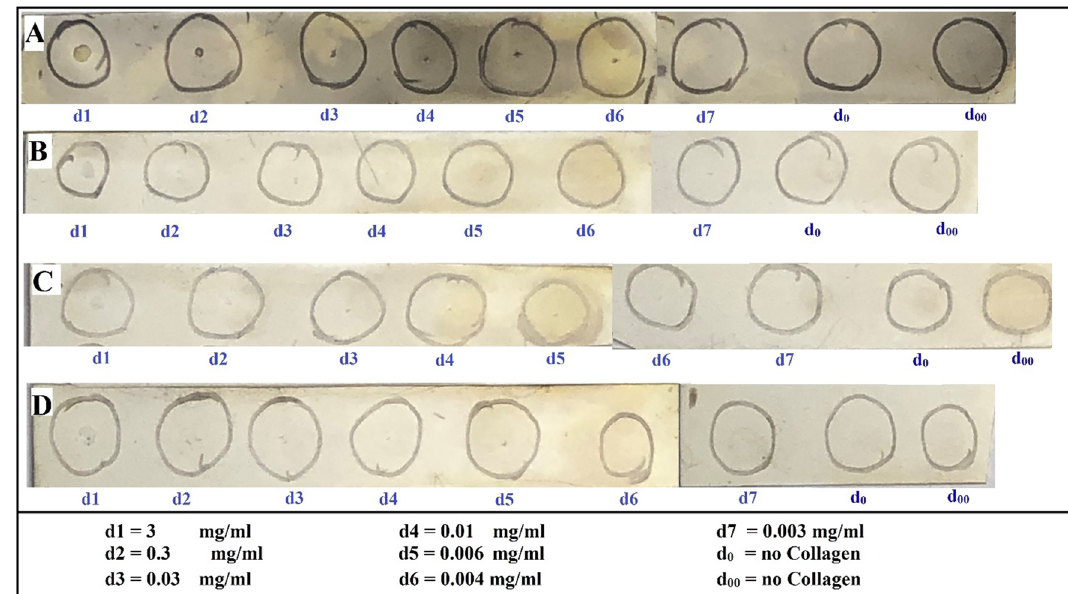
Figure 8. Dot-blot showing positive interaction of INP with Collagen-1: A – D : Collagen-1 (0.5ul of solutions at indicated concentrations d1–d7) was added to the center of each circle. A – C , Incubated with INPs (2.5 mg/ml); D , Not incubated with INP. A , D , Both primary and secondary antibodies; B , Secondary antibody only; C , No antibody